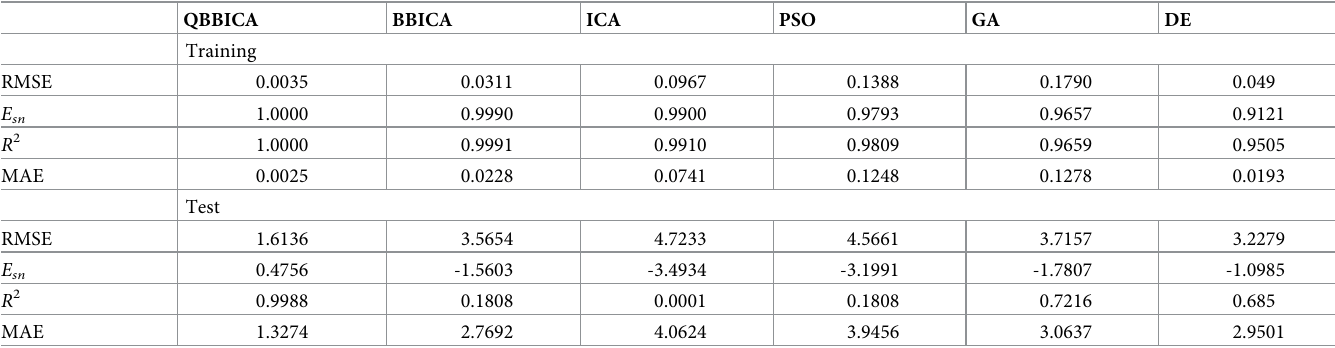
Table 8. Performance indices of ReLU-FCM.